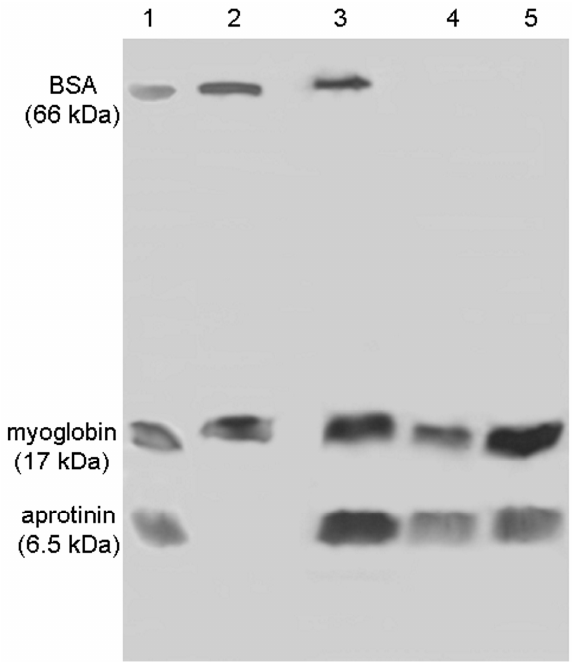
Figure 6. SDS-PAGE analysis of the FCSNP washes and elutions after incubation with high and low molecular weight model proteins for 60 min. Model proteins BSA (66 kDa), myoglobin (17 kDa), and aprotinin (6.5 kDa) (lane 1). Excess of proteins was removed in wash with PB (lane 2) and elution with 50% isopropanol (lane 3). Simultaneous exclusion of albumin and capture of myoglobin and aprotinin was achieved in elutions with 50% methanol and ACN + NH 4 OH (lanes 4 and 5, respectively).